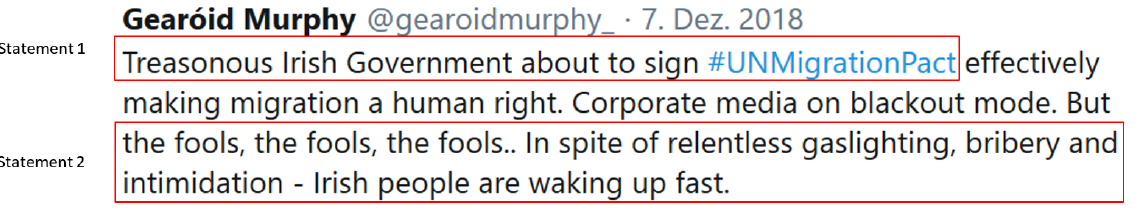
Figure 1. Coding of a tweet: Example for the coding approach. Source: Murphy